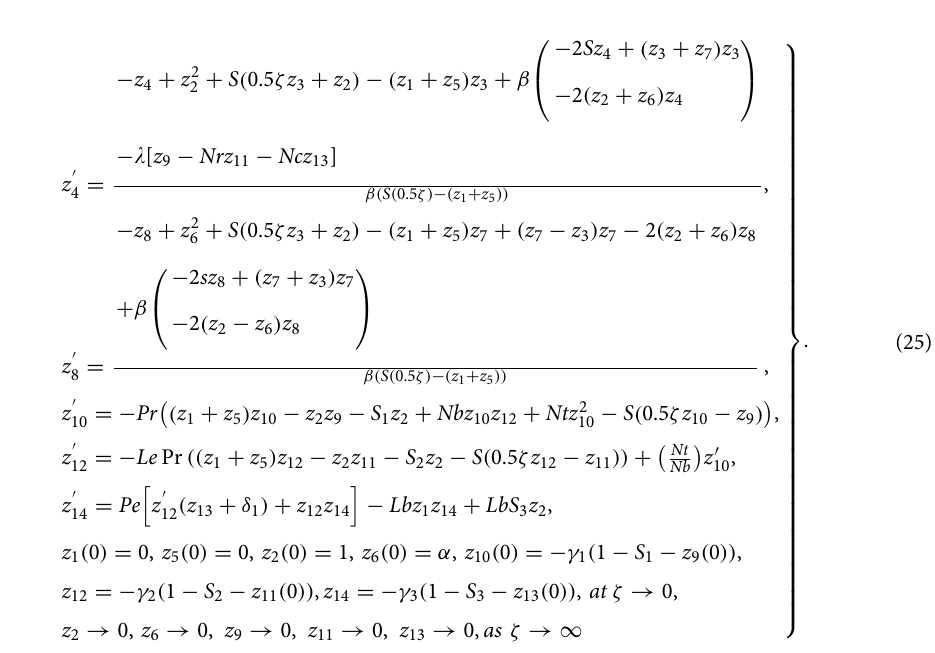
Figure 2. Illustration of Pr and Rd over-temperature θ when α = 0.5, Nb = 0.2, Nt = 0.3, S = 0.5, (cid:31) = 0.5, β = 0.2